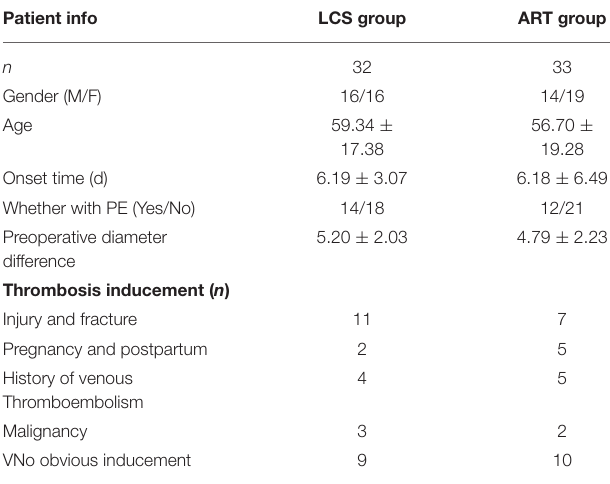
TABLE 1 | Basic information of the two groups of